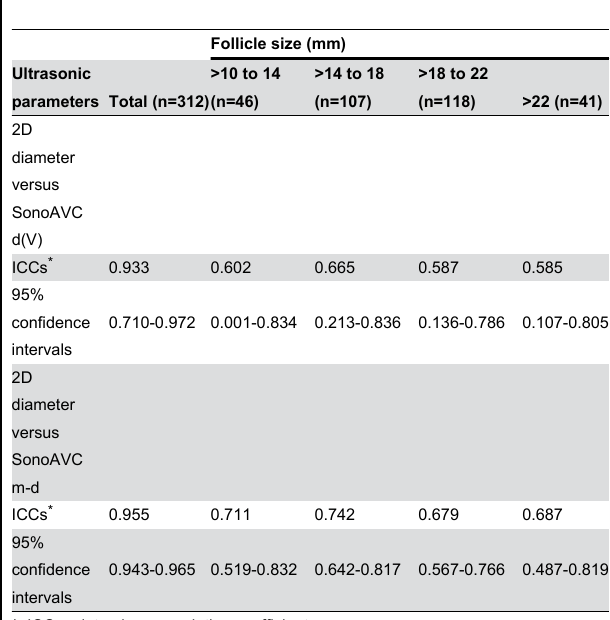
Table 1. Correlation coefficients of 2D follicular diameter and SonoAVC-generated parameters in various follicle category.